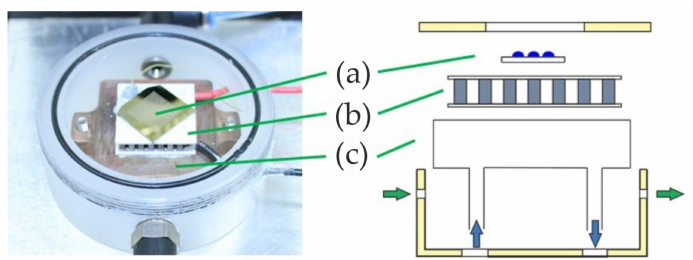
Figure 2. Photograph ( left ) and vertical section scheme ( right ) of the freezing cell. The freezing chip ( a ) lies directly on the thermoelectric cooler (TEC) ( b ), which is fixed to the heat exchange device ( c ) via a conductive adhesive. The cell can be flushed with dry nitrogen (symbolized by the green arrows) to remove humidity, which could interfere with the measurements. The blue arrows trace the flow of cooling water, taken from a water-ice mixture to cool the warm side of the TEC. The electronic connections (black and red wire) of the TEC are visible in the picture on the